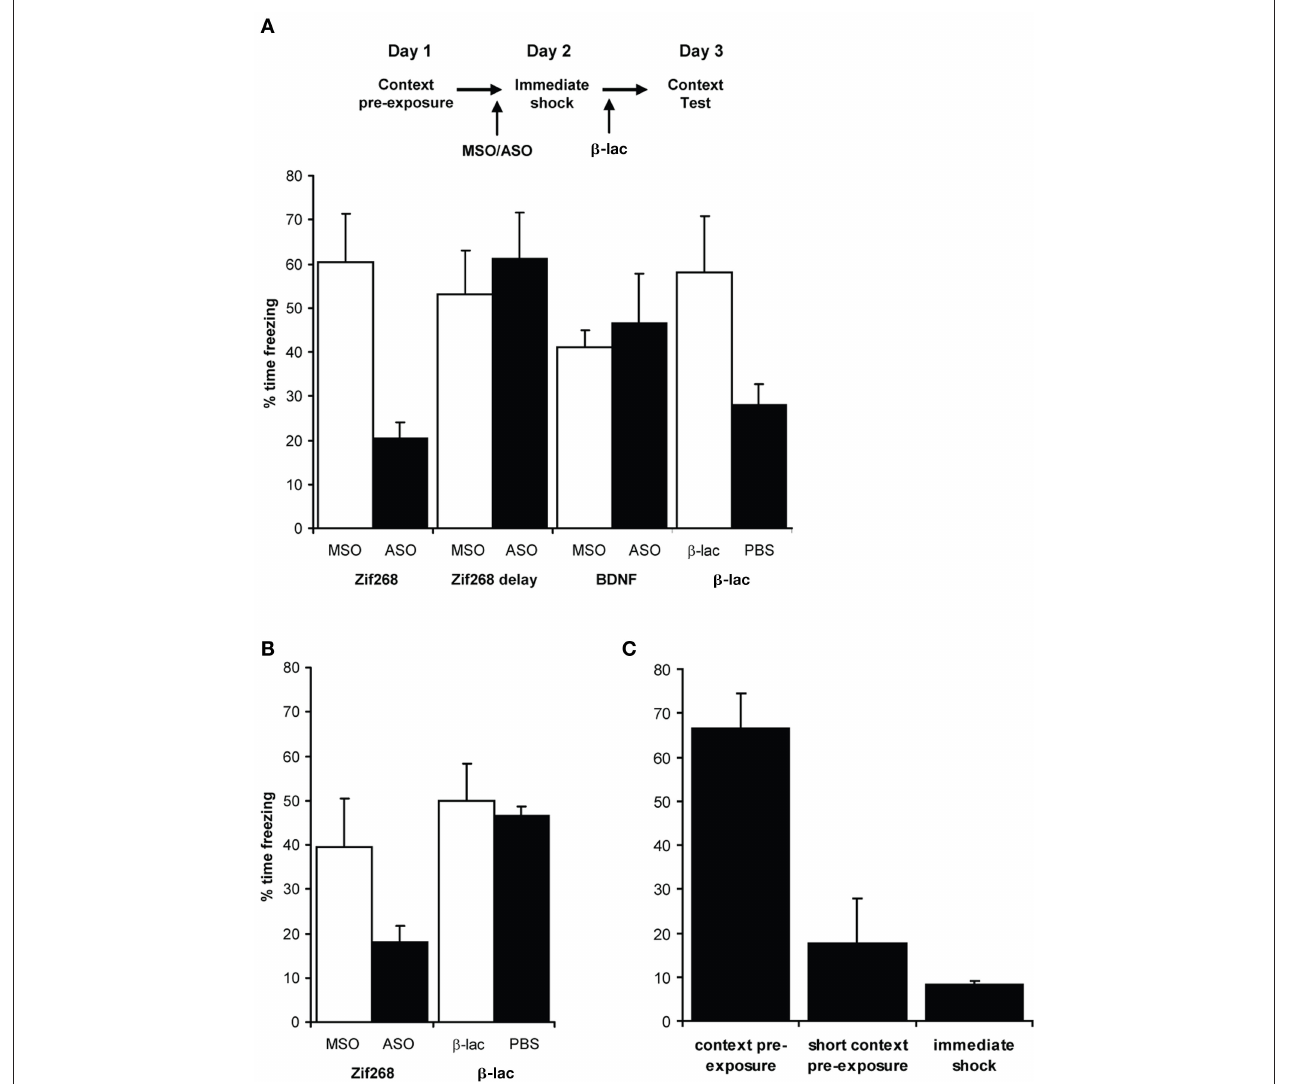
Figure 4 | updating the contextual representation requires memory destabilization and reconsolidation. (A) Rats were pre-exposed to the context, and then infused into the dorsal hippocampus at the time of a subsequent immediate shock, with the updated memory assessed in a contextual fear test. Whereas knockdown of BDNF had no effect, knockdown of Zif268 and inhibition of synaptic protein degradation ( β -lac) both